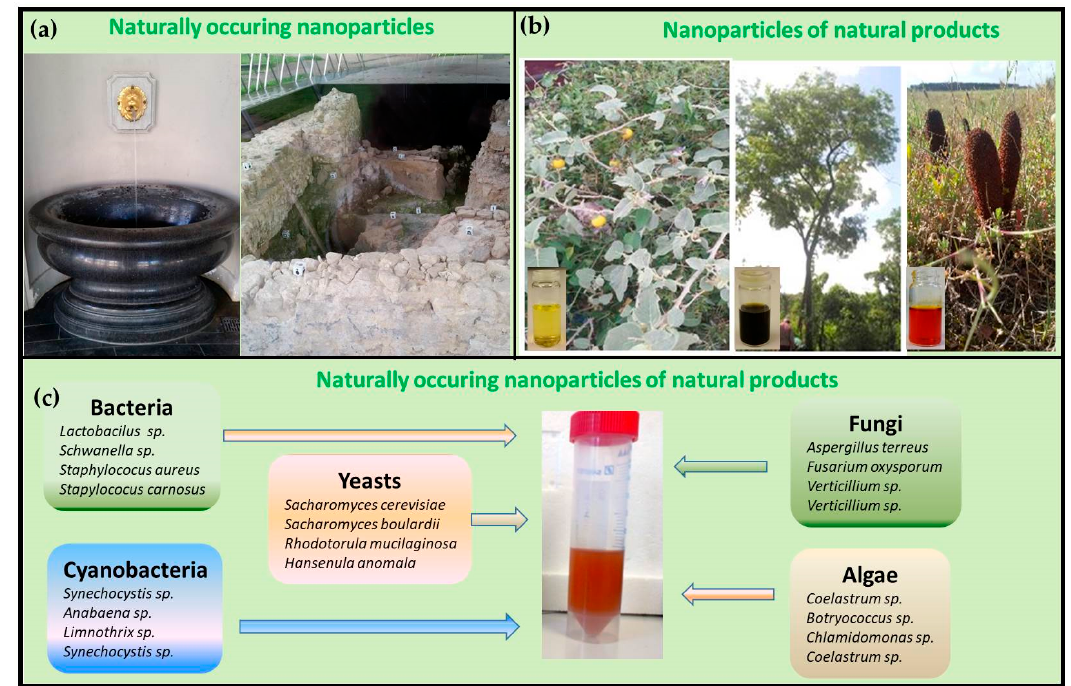
Figure 2. Examples of natural and biological materials which contain nanoscopic particles. ( a ) Naturally occurring nanoparticles of inorganic, elemental sulfur, for instance, are found at mineral wells rich in hydrogen sulfide, such as the Elisenbrunnen in Aachen. ( b ) In contrast, mechanically produced nanomaterials of natural products have been evaluated for medical and agricultural applications. ( c ) Eventually, there are also naturally produced nanomaterials of natural, biological products, such as nanoscopic particles of elemental selenium coated with microbial proteins which are formed by bioreductive or oxidative metabolism in bacteria and fungi.